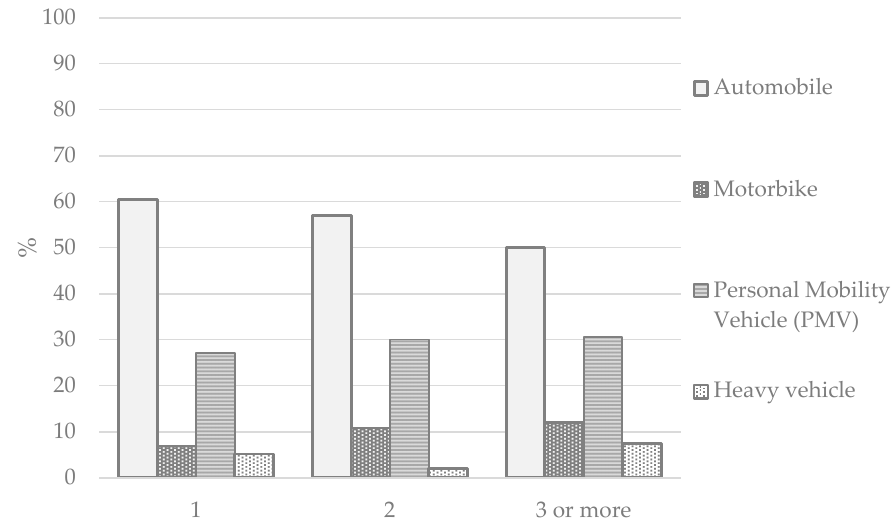
Figure 3. Number of vehicles available in the household by typology.